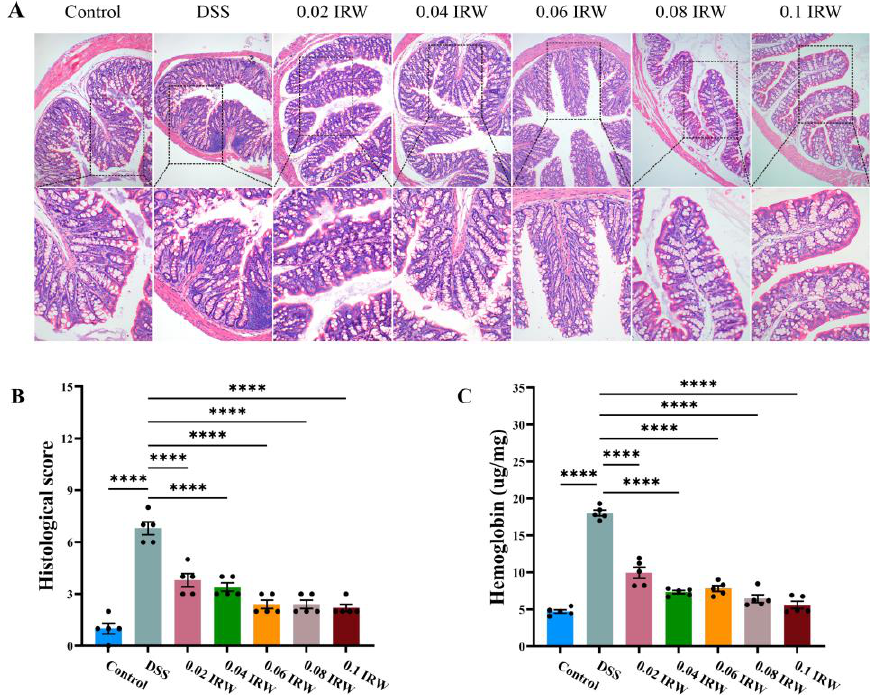
Figure 2. Effects of different concentrations of IRW on colonic morphology in mice: ( A ) HE staining of the colon, ( B ) histological score of the colon, and ( C ) colon tissue hemoglobin content (n = 5); **** indicates p < 0.0001.